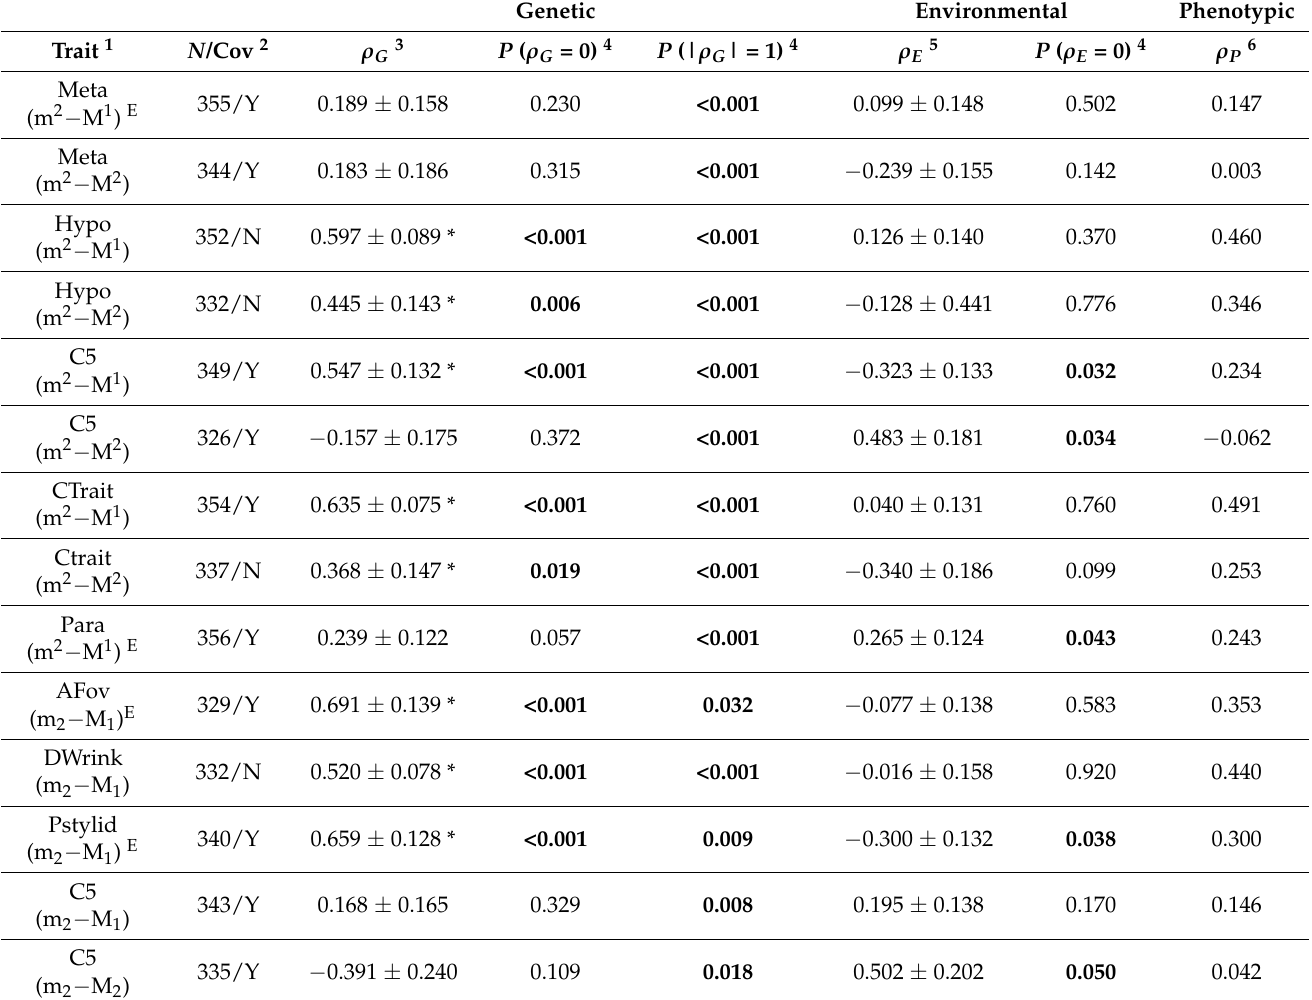
Table 3. Variance components correlations: paired deciduous and permanent morphology. Genetic Environmental